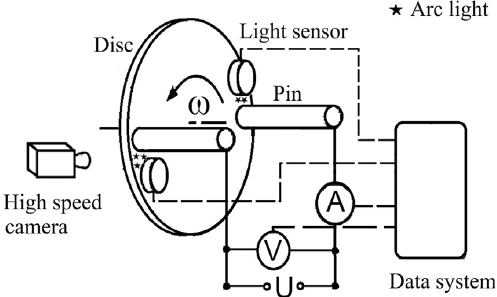
Figure 3. Configuration of the test bench from articles by Yang Z. et al. [29–31]. Copyright (2023), with permission from Elsevier. Table 2. List of test benches used to study slip